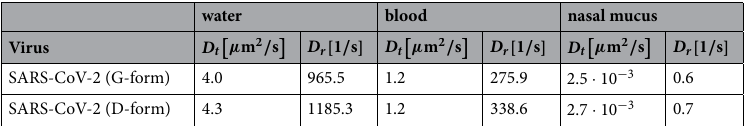
Table 1. Translational and rotational diffusivities computed for different virions in water, blood, and nasal mucus. The diffusivities of the virions are computed using Eq. (5) in “Methods” section. The viscosity η values are for water = 0.001 Pa · s , blood = 0.0035 Pa · s . 24 and, nasal mucus = 1.6 Pa · s 16 . Temperature = 298.15 K, and k b = 1.38064852 · 10 − 23 m 2 kg / s 2 K